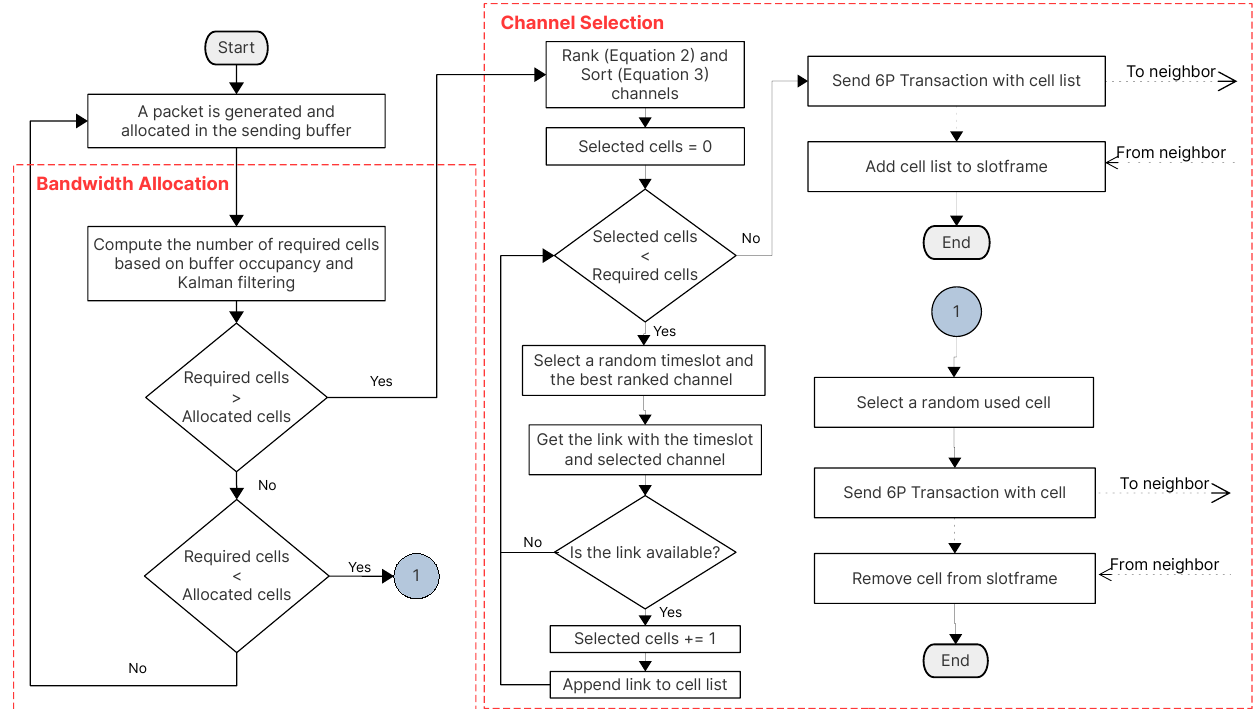
Figure 3. The complete bandwidth allocation, channel selection, and 6P negotiation processes of the Channel Ranking Scheduling Function